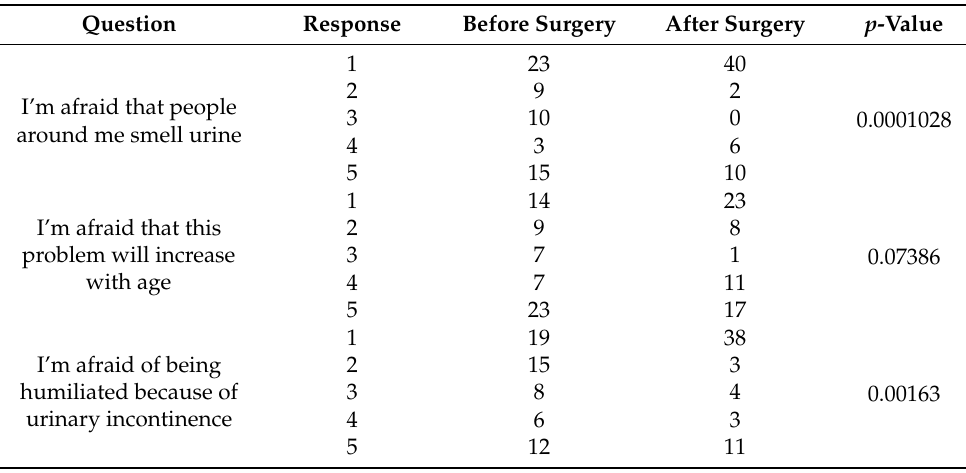
Table 6. Social embarrassment responses from IQoL questionnaire from women before and after